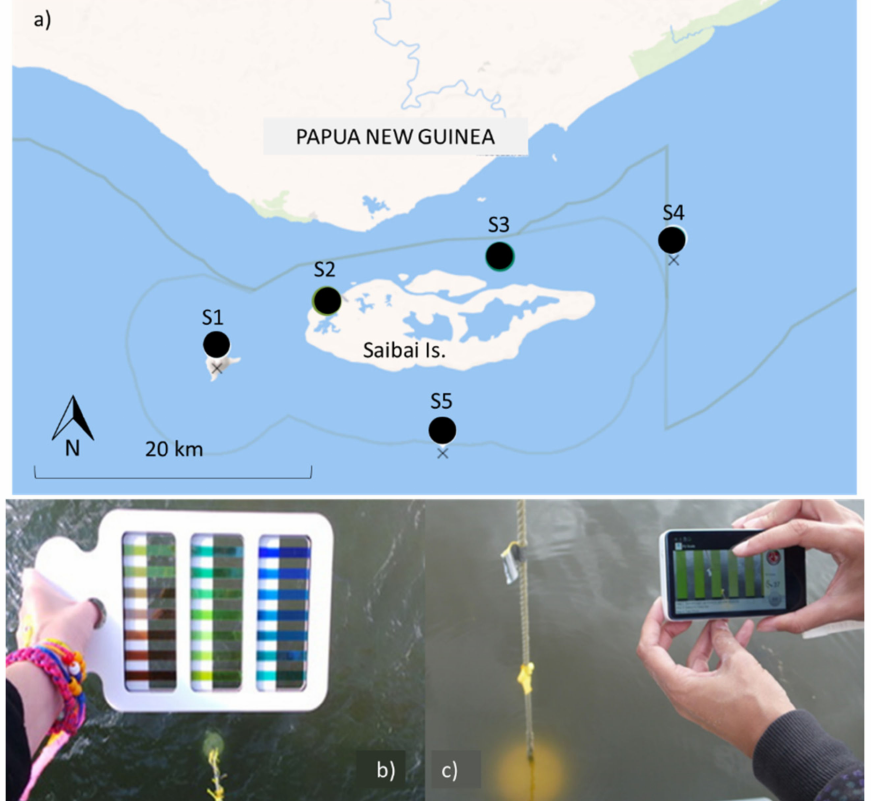
Figure A3. ( a ) Map showing the location of field FU colour, Secchi Disk Depth and SSC measurements collected in November 2020 ([22], modified). FU scale measurements in the field using a Secchi Disc showing ( b ) the historical glass encased FU scale and ( c ) the FU-scale phone App. [50,77–79]. Map extracted and modified from the Eye on water website [54] and centred on Saibai Island (Figure 1 for the location of Saibai